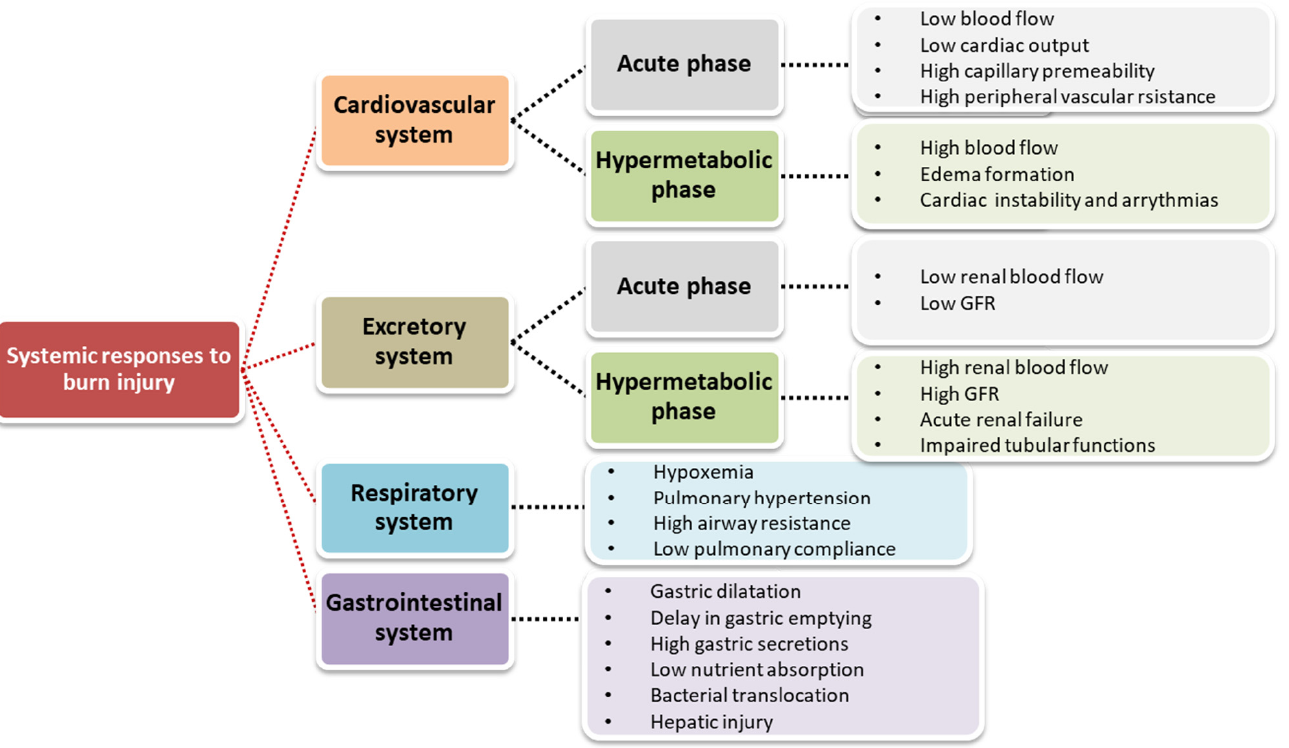
Figure 2. Systemic response to burn injury based on [47] .